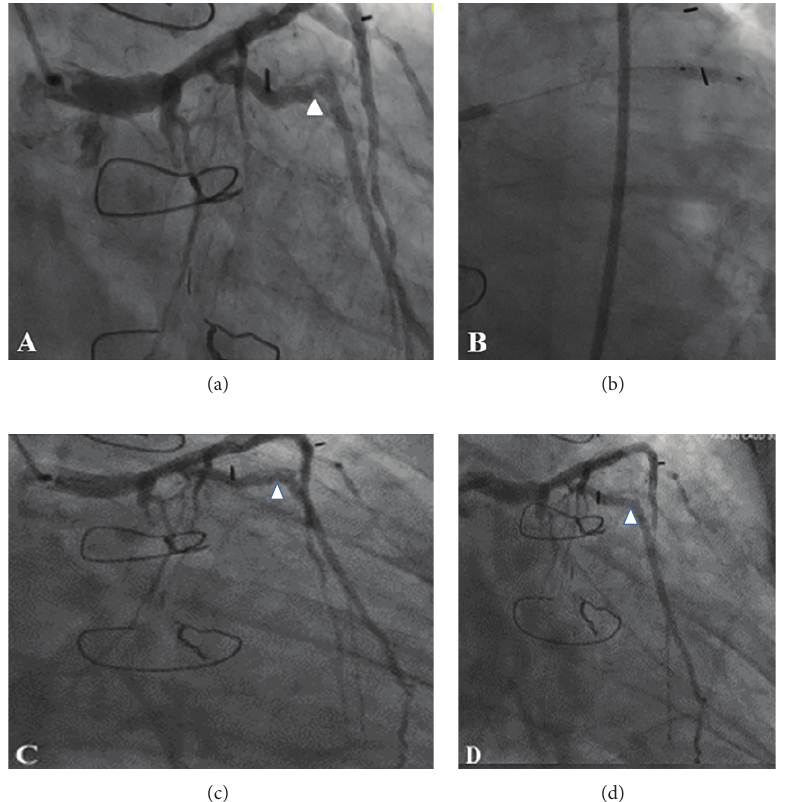
Figure2:(a)RAO(rightanterioroblique)caudalviewoftheleftcoronaryarterysystemshowingasignificantlesion(arrowhead)intheramus intermedius branch at the bend in the proximal to mid portion. (b) Cutting balloon angioplasty (CBA) and post CBA angiogram (c) with dissection (arrow head). (d) Postintervention angiogram showed TIMI III flow without any dissection (TIMI: thrombolysis in myocardial